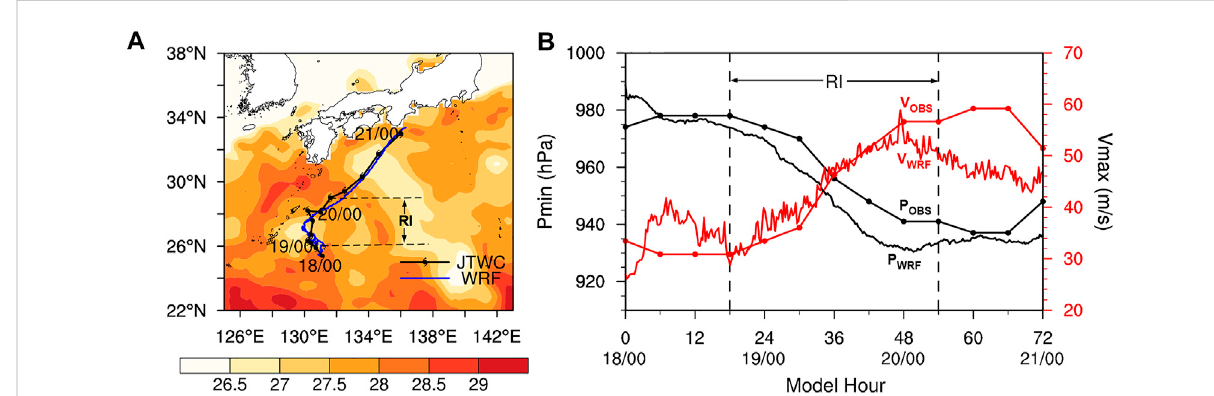
FIGURE 3 (A) Comparison of the track between the observations (black line with typhoon symbols) and simulations (blue line with typhoon symbols) superimposed on the sea surface temperature fi eld (shaded areas, ° C) at 0000 UTC 18 September 2011, and (B) time series of the maximum surface windspeed(redlines,m s − 1 )andminimumcentralpressure(blacklines,hPa)oftheobservations(OBS,dottedlines)andsimulations(WRF,solidlines).